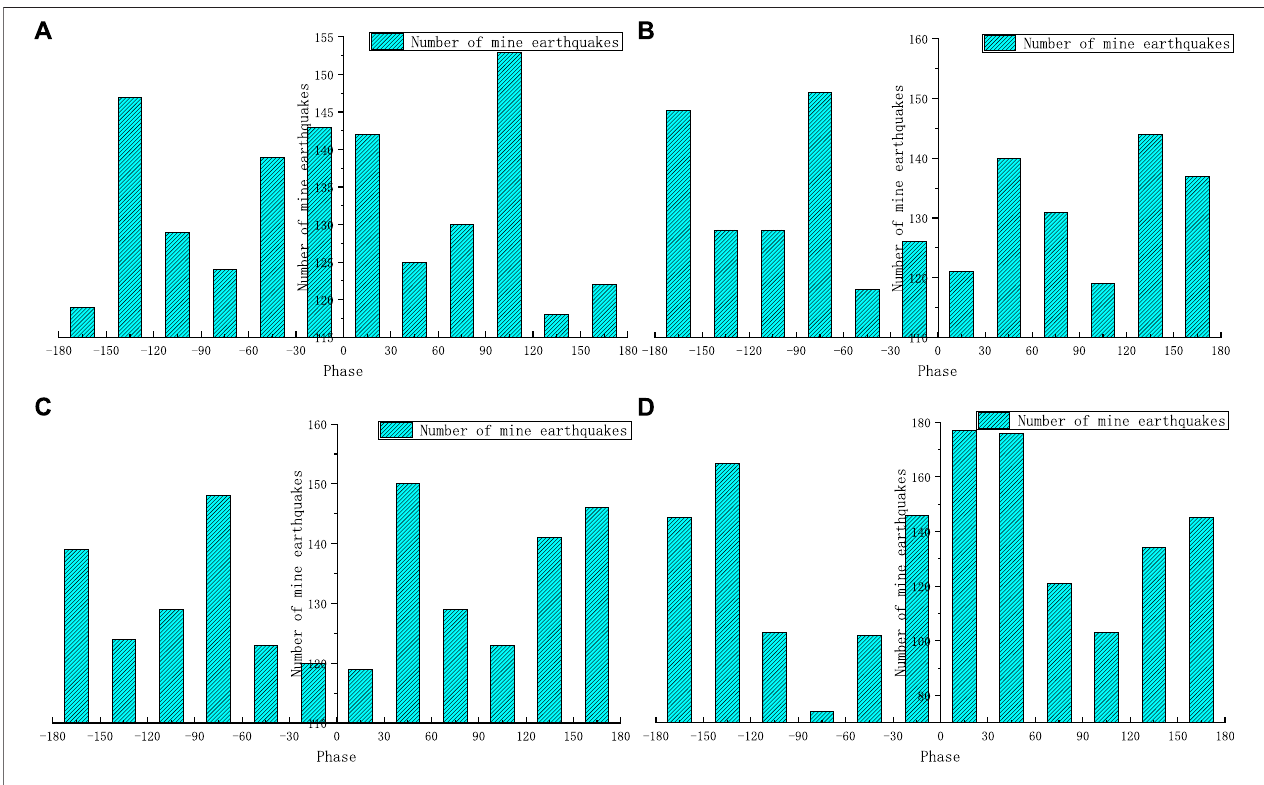
FIGURE 6 | Statistical histogram of the mine earthquake 0.5 ≤ M L < 1.0 frequency.